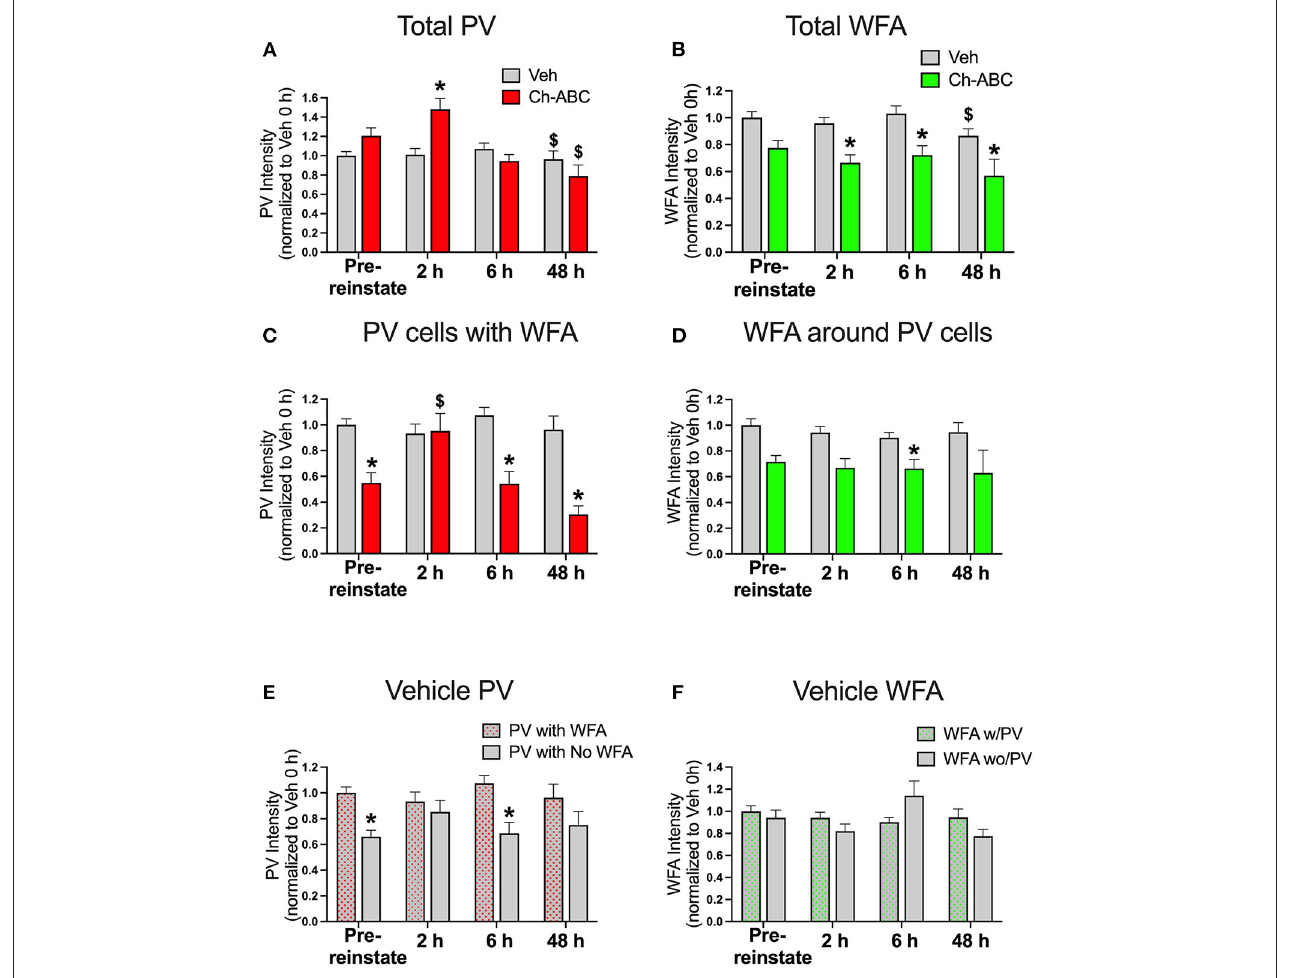
FIGURE 2 | Cocaine-primed reinstatement does not alter PV or WFA intensity in vehicle controls, while Ch-ABC treatment in the mPFC increases PV intensity 2h post-reinstatement. (A) Intensity of total labeled PV cells in prelimbic PFC; PV intensity of both vehicle and Ch-ABC-treated rats decreased at 48h compared within group to intensity at pre-reinstatement (pre-reinstate); intensity of Ch-ABC-treated animals increased at 2h compared to vehicle-treated animals. (B) Intensity of total labeled WFA cells in prelimbic PFC; WFA intensity in Ch-ABC-treated animals decreased at 2, 6, and 48h compared to vehicle treated animals; intensity of WFA in vehicle-treated animals at 48h decreased compared to their pre-reinstatement levels. (C) Intensity of PV cells containing WFA in prelimbic PFC; intensity of PV cells in Ch-ABC-treated animals was decreased at pre-reinstatement and at 6 and 48h compared to vehicle-treated animals; intensity of PV cells in Ch-ABC-treated animals increased at 2h compared to pre-reinstatement levels in Ch-ABC-treated animals. (D) Intensity of WFA cells in prelimbic PFC containing PV; intensity of WFA in Ch-ABC-treated animals decreased at 6h compared to vehicle-treated animals. (E) Intensity of PV with or without WFA in prelimbic PFC in vehicle groups; intensity of PV devoid of PNNs (without WFA) decreased at pre-reinstatement and at 6h compared to PV cells with PNNs (with WFA). (F) Intensity of WFA with or without co-labeled PV in prelimbic PFC. Data are mean ± SEM. All values were normalized to vehicle pre-reinstatement values. For vehicle: pre-reinstate n = 10; 2h n = 7; 6h n = 6; 48h n = 5. For Ch-ABC: pre-reinstate n = 6; 2h n = 6; 6h n = 5; 48h n = 2. $ P < 0.05, compared within-group to Pre-reinstate; * P < 0.05 compared to vehicle group at the same time